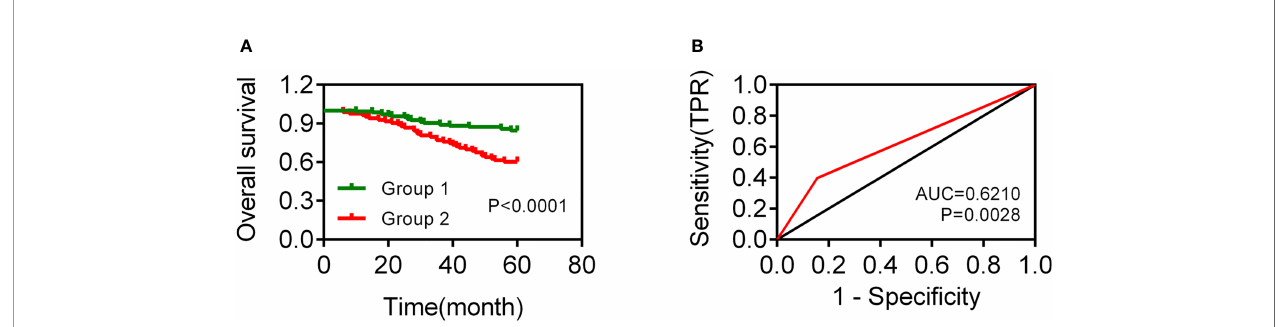
FIGURE 2 | Analysis of the TNBC prognostic model based on MET and FASN expression. (A) The overall survival curve of TNBC patients with group 1 (2 points, both positive expression of MET and FASN) and group 2 (0 and 1 point, positive expression of MET or FASN, and negative expression of MET and FASN). (B) The AUC value of ROC curve in 5-year for